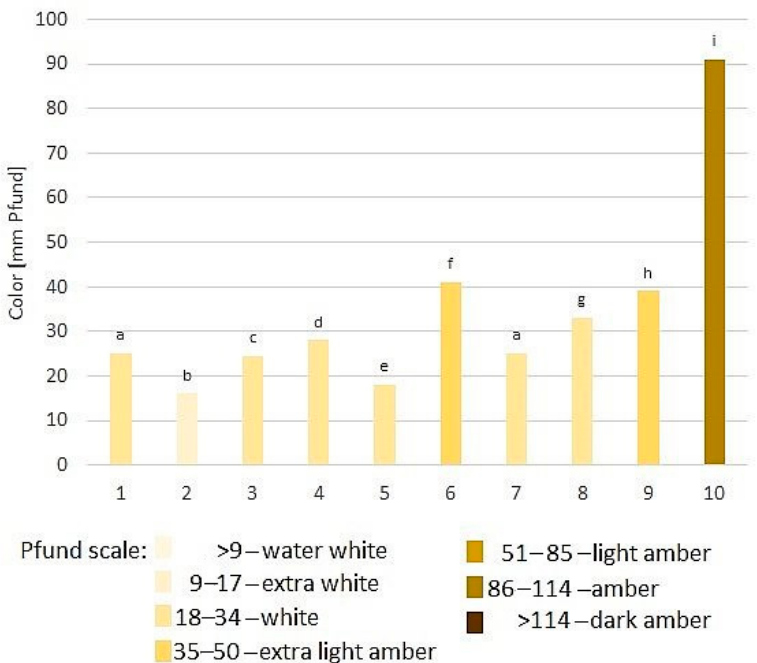
Figure 1. Color analysis of goldenrod honey samples (1–10). Different letters above the bars indicate significant differences ( p = 0.05).